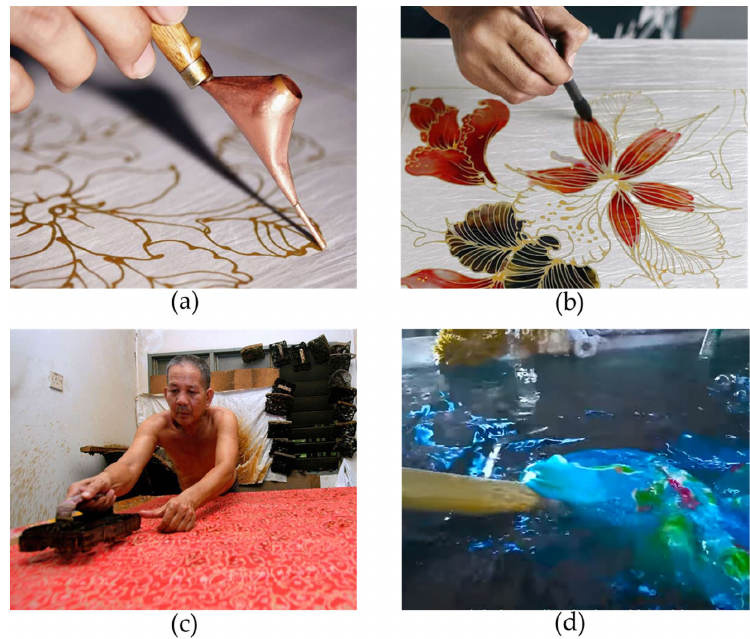
Figure 2. Schematic activities of Batik production: ( a ) canting process; ( b ) paint dyeing process; ( c ) block printing process; ( d ) wax removal process [7].